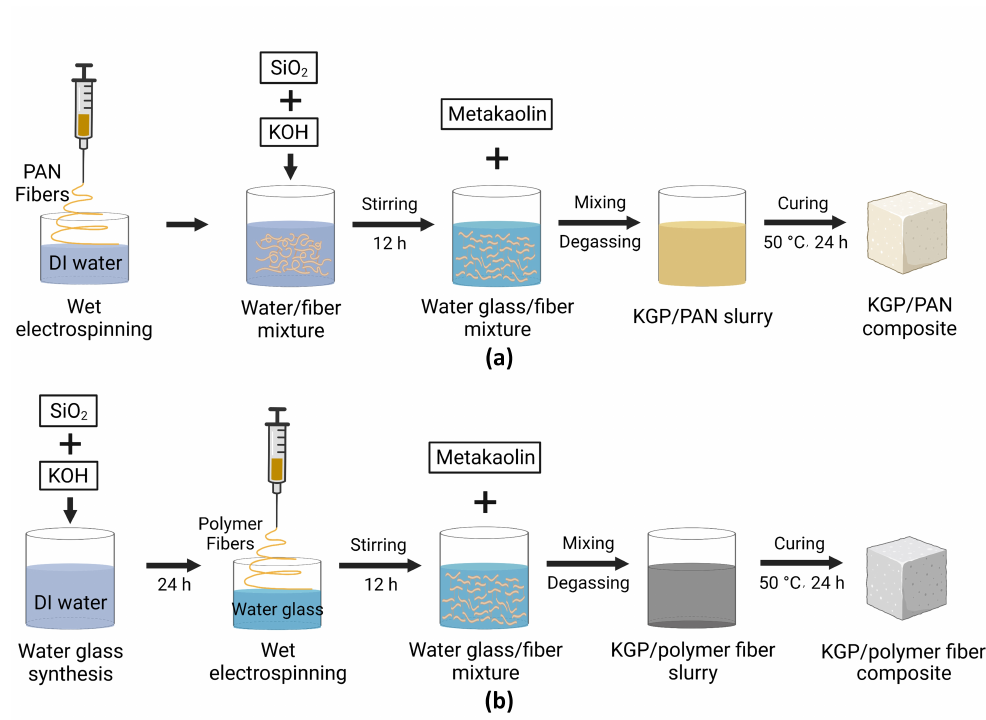
Figure 2. Synthesis process of electrospun-fiber-reinforced geopolymer composites: ( a ) Using DI water as the liquid-bath collector. ( b ) Using the waterglass solution as the liquid-bath